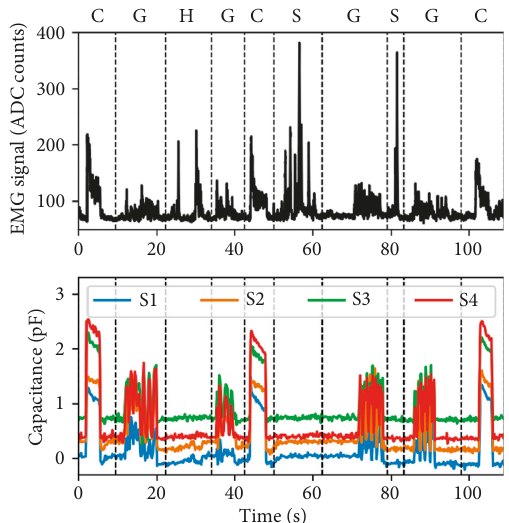
Figure 5: Correlation between EMG and force-sensing appliance signals for bruxism-related events (clenching (C) and grinding (G)). Rejection of false positives is shown (EMG signals due to speaking (S) and moving the head